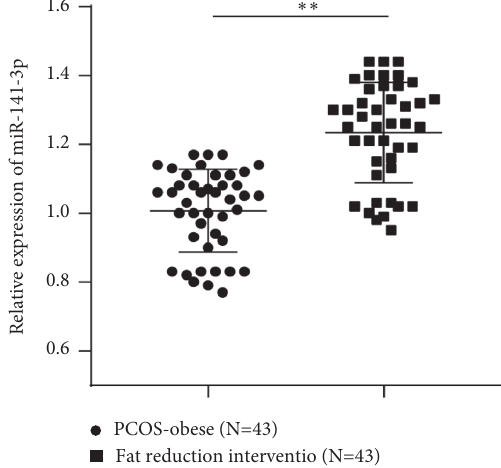
Figure 2: Changes of clinical parameters and miR-141-3p ex- pression in PCOS-obese patients before and after intervention of fat reduction. miR-141-3p expression in serum of PCOS-obese pa- tients before and after fat reduction intervention was detected by RT-qPCR. Data are expressed as mean ± standard deviation. Data were analyzed using t -test. ∗∗ P < 0 .